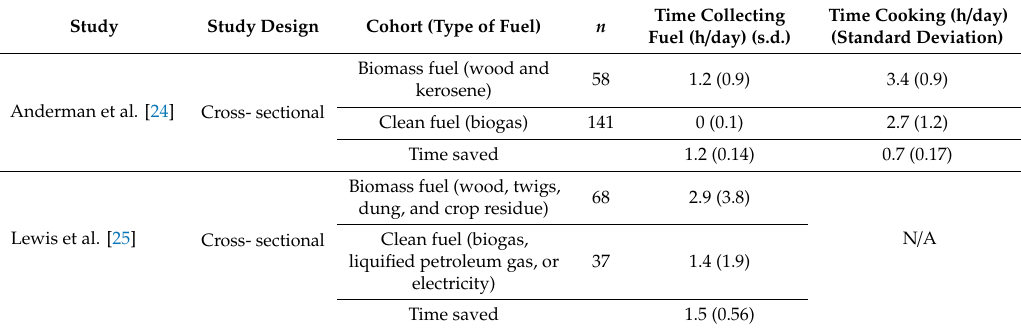
Table 2. Eligible